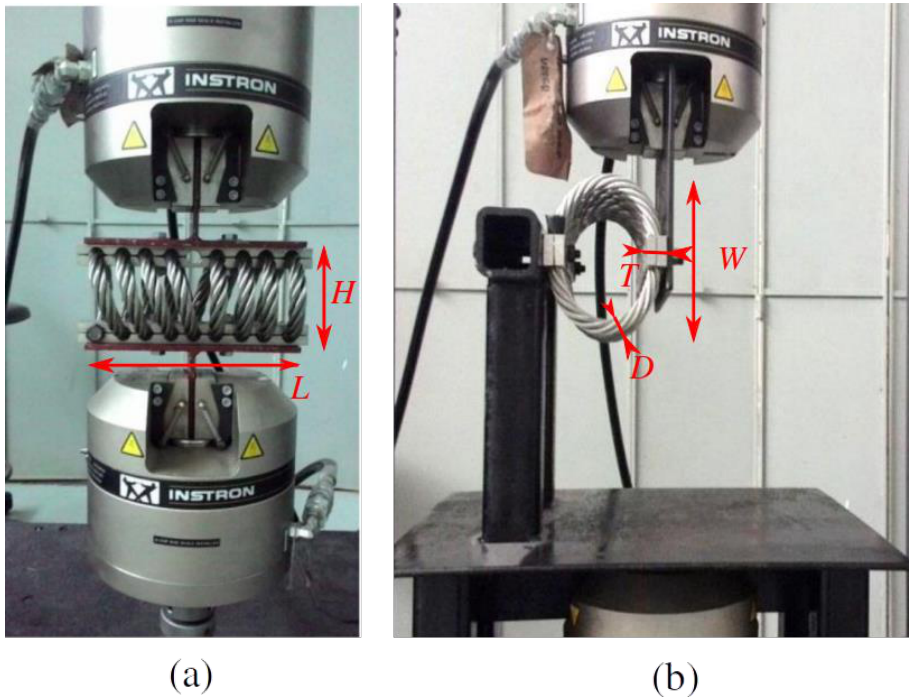
Figure 2. WRI geometry and test setup: ( a ) compression-tension direction; ( b ) roll direction. Table 1. Test specimens: geometry and stiffness properties (# of coils = 8 for all specimens).